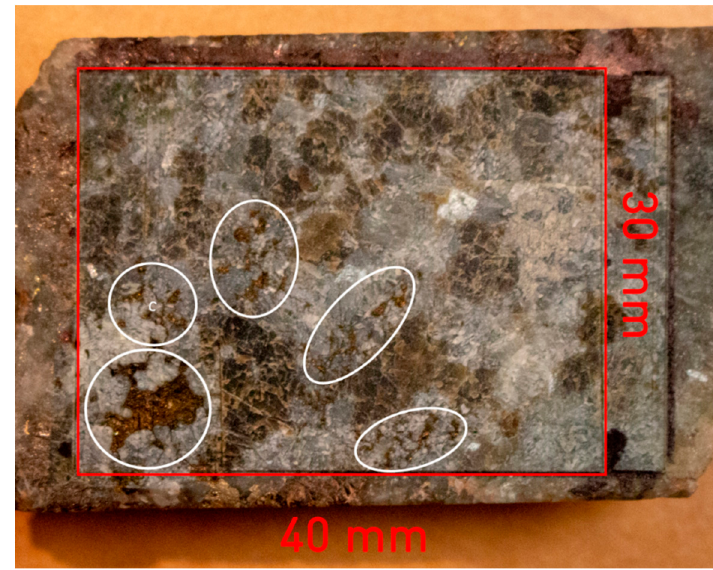
Figure 1. Optical image showing, outlined in red, the laser-induced breakdown spectroscopy (LIBS) scanned area of the analyzed drill core fragment. The ellipses locate sulfide-based minerals.